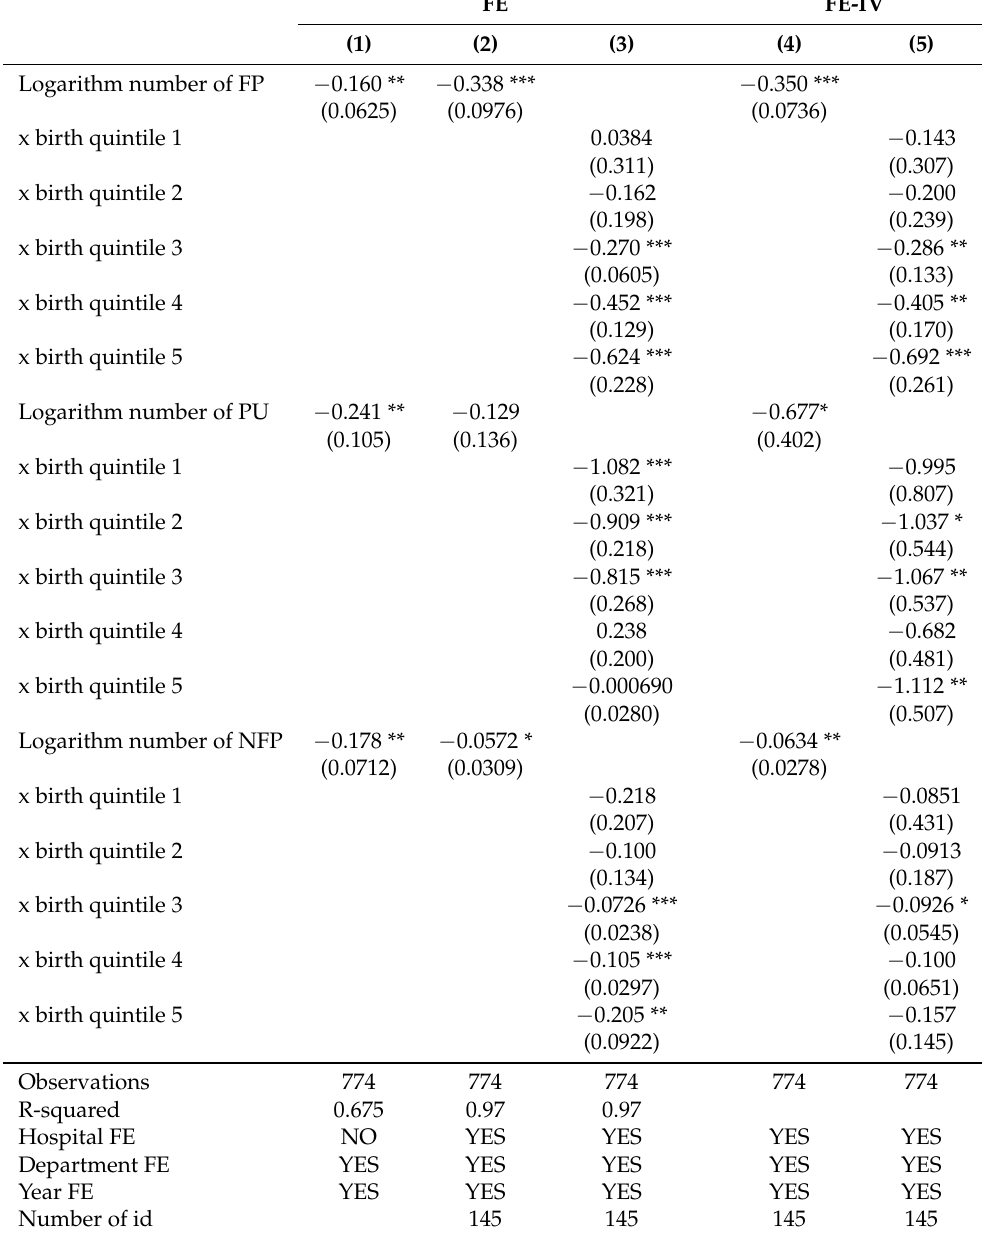
Table 4. Reduced Analysis on substitution between maternity units: Focal unit is